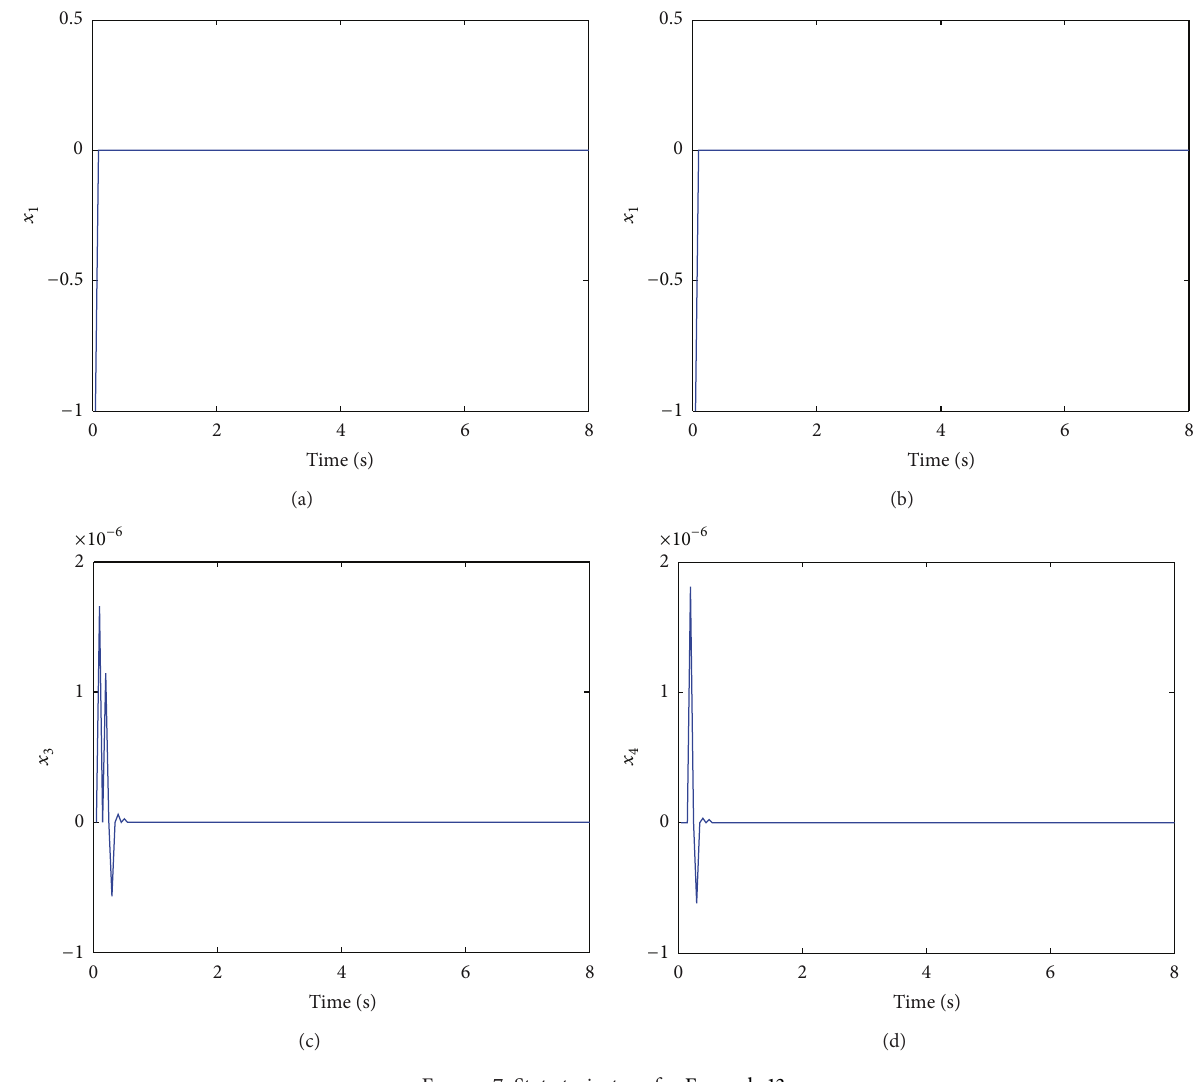
Figure 7: State trajectory for Example